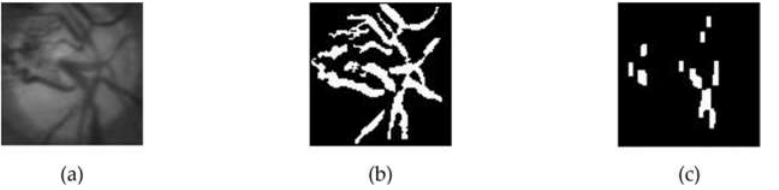
Figure 5. The extraction process of blood vessels on the optic disc; ( a ) optic disc on the green layer; ( b ) the extraction result of blood vessels on the optic disc; ( c ) the result of elimination of horizontal blood vessels.